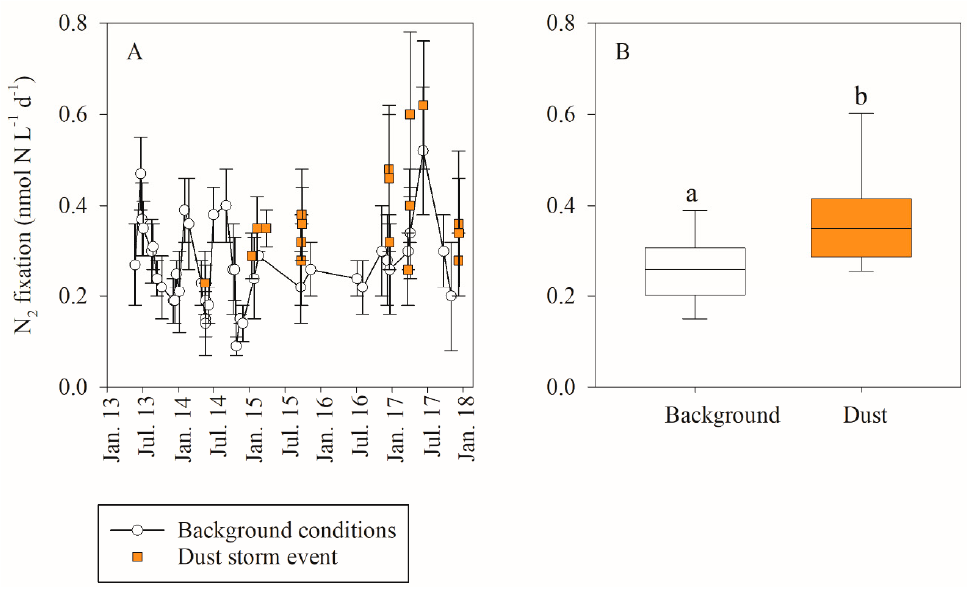
Figure 4. Surface (1–2 m) N 2 fixation ( A ) temporal variability and ( B ) distribution at the coastal SEMS, 2013–2017. Measurements were taken during “typical” days (white, Supplementary Table S1, n = 40) and during dust storms (orange, Supplementary Table S2, n = 18). Box-whisker plots show interquartile range (25th to 75th percentile) of the dataset. Horizontal lines within the boxes represent median value. Letters above the box-plots represent significant differences ( t -test, p < 0.05) for mean values between background and dust measurements.